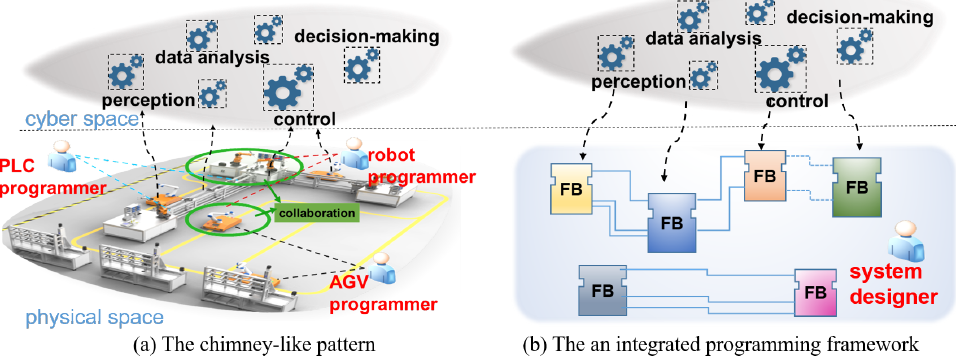
Figure 1. Current and desired programming patterns for cyber-physical production system